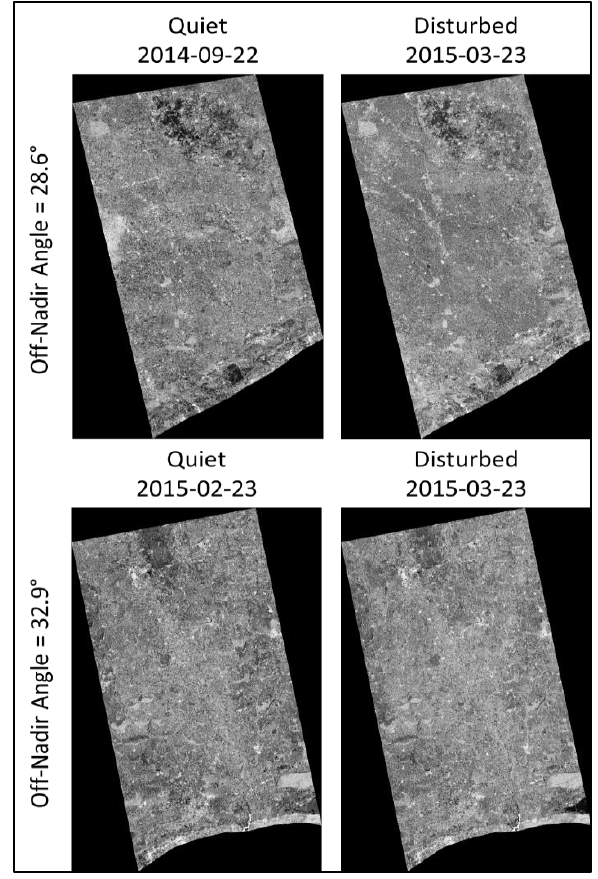
Figure 5. Common region of interest chosen for S 4